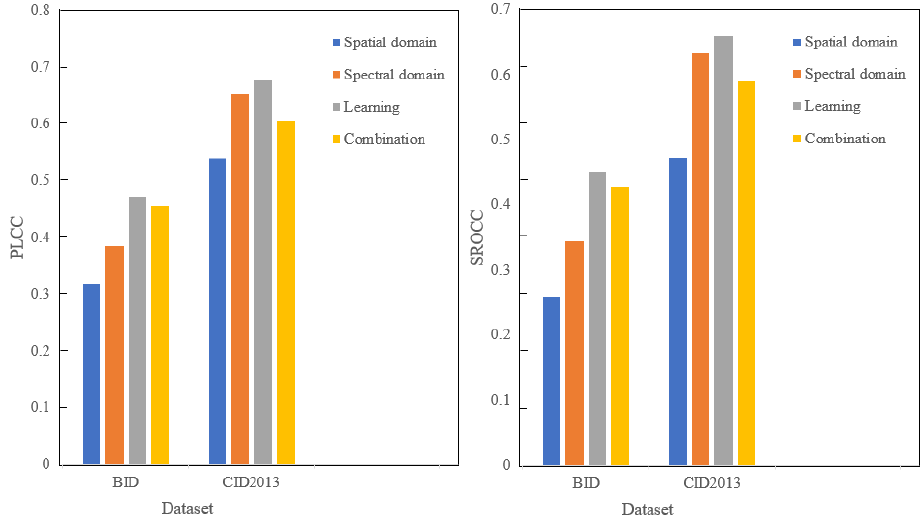
Figure 11. PLCC and SROCC values of different groups of methods on natural distortion datasets.